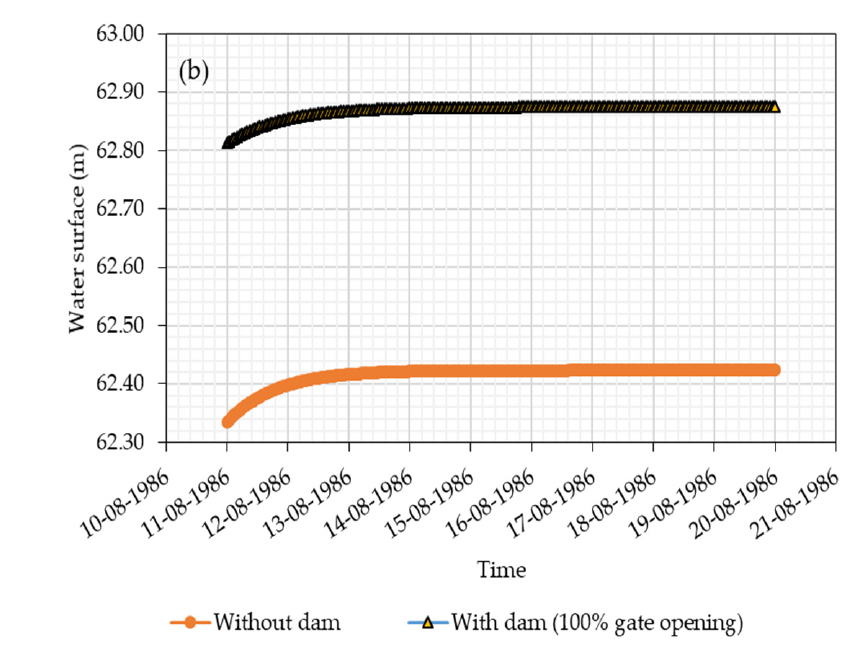
Figure 10. Water surface elevation for 1000 and 10,000 years discharge (considering discharge data at Dowleswaram and corresponding water levels at Polavaram) from Polavaram to Dummugudem.